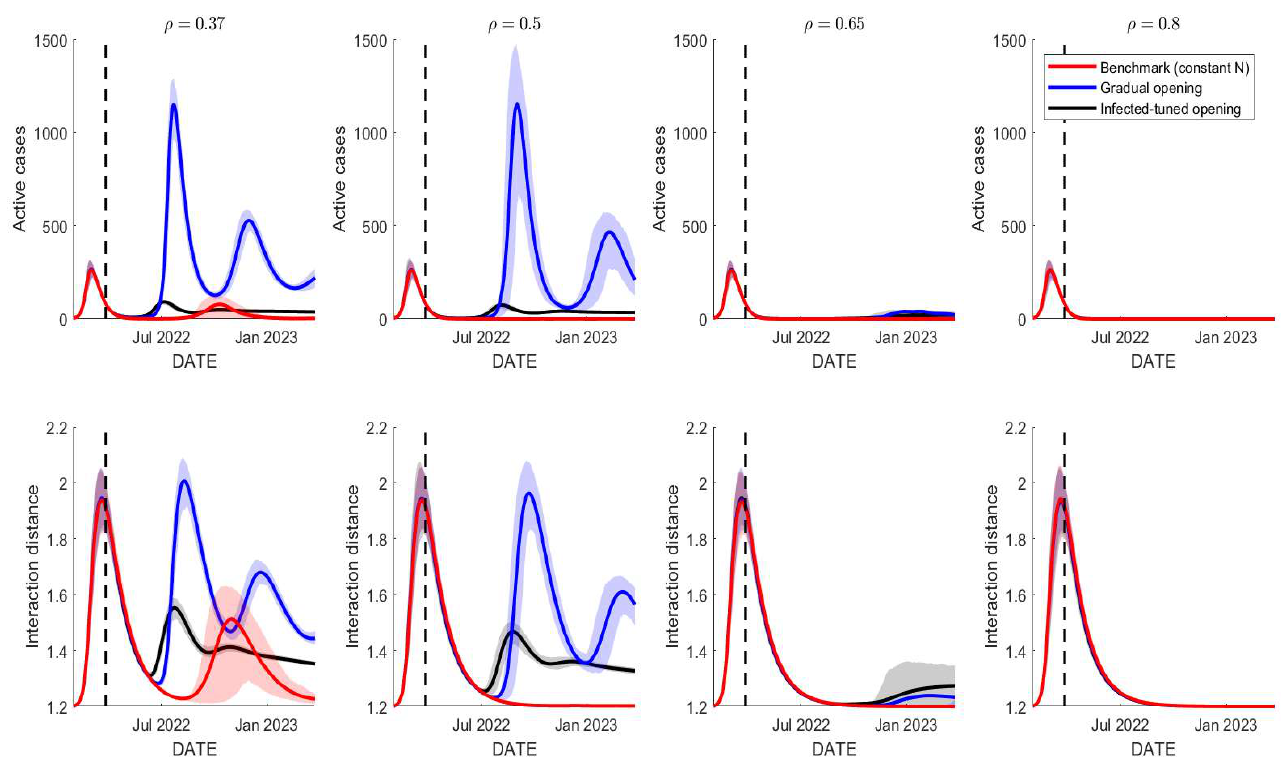
Figure 9. Simulations of the three school reopening schemes under different vaccine efficacies. Im- proving the vaccine efficacy should reduce the expected numbers of cases. The highest vaccine effi- cacy in response to the Omicron variant is about 71%